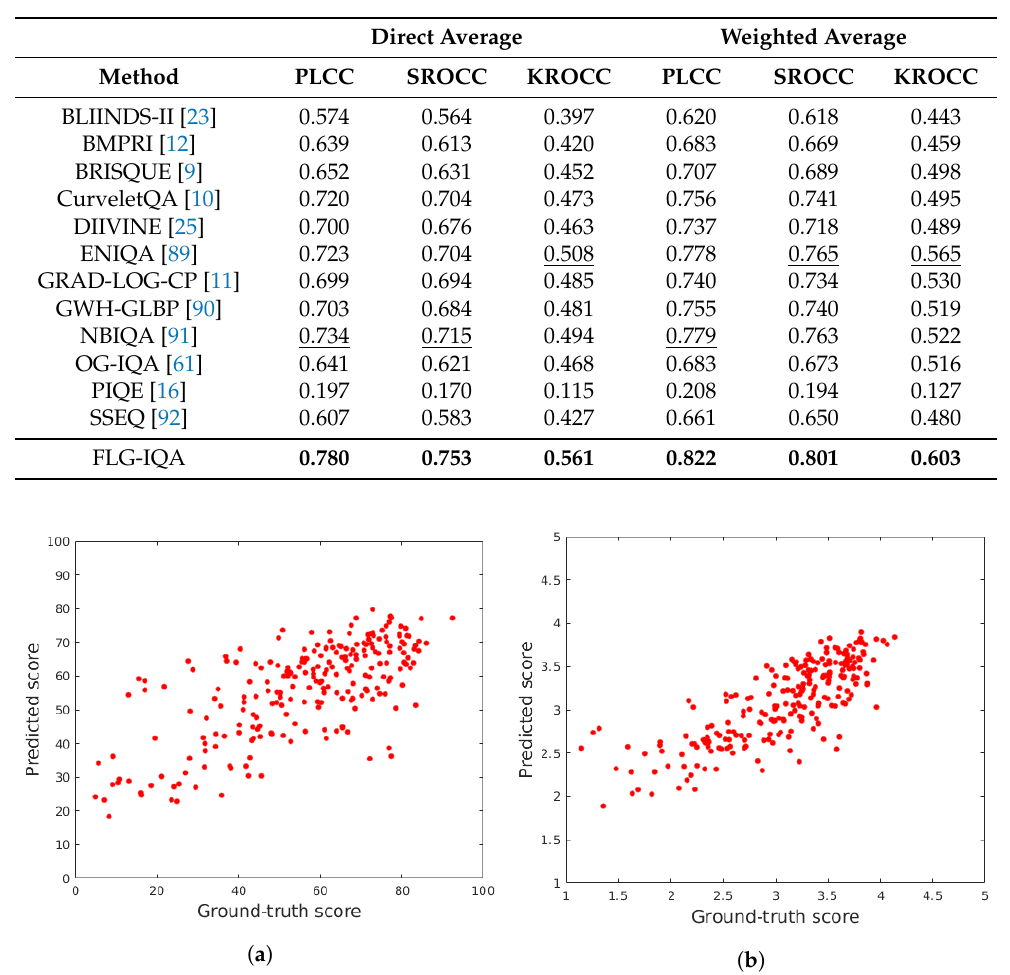
Figure 6. Ground truth scores versus predicted scores in ( a ) CLIVE [45] and ( b ) KonIQ-10k [46] test